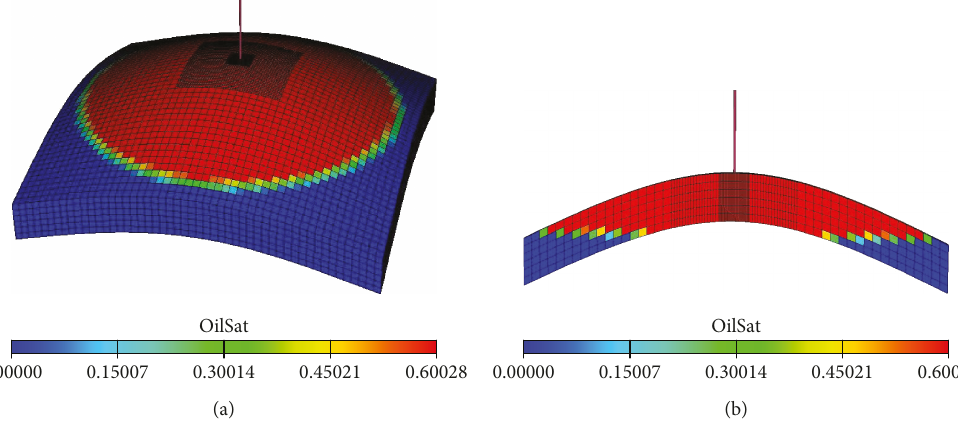
Figure 1: The anticline model: 3D (a) and 2D cross-section pro fi le (b). Table 1: Reservoir model